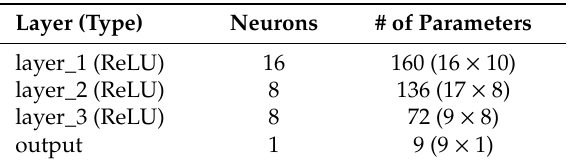
Table 3. Structure of the Artificial Neural Network (ANN). Total number of parameters is 377, as the result of the sum of 160 + 136 + 72 +